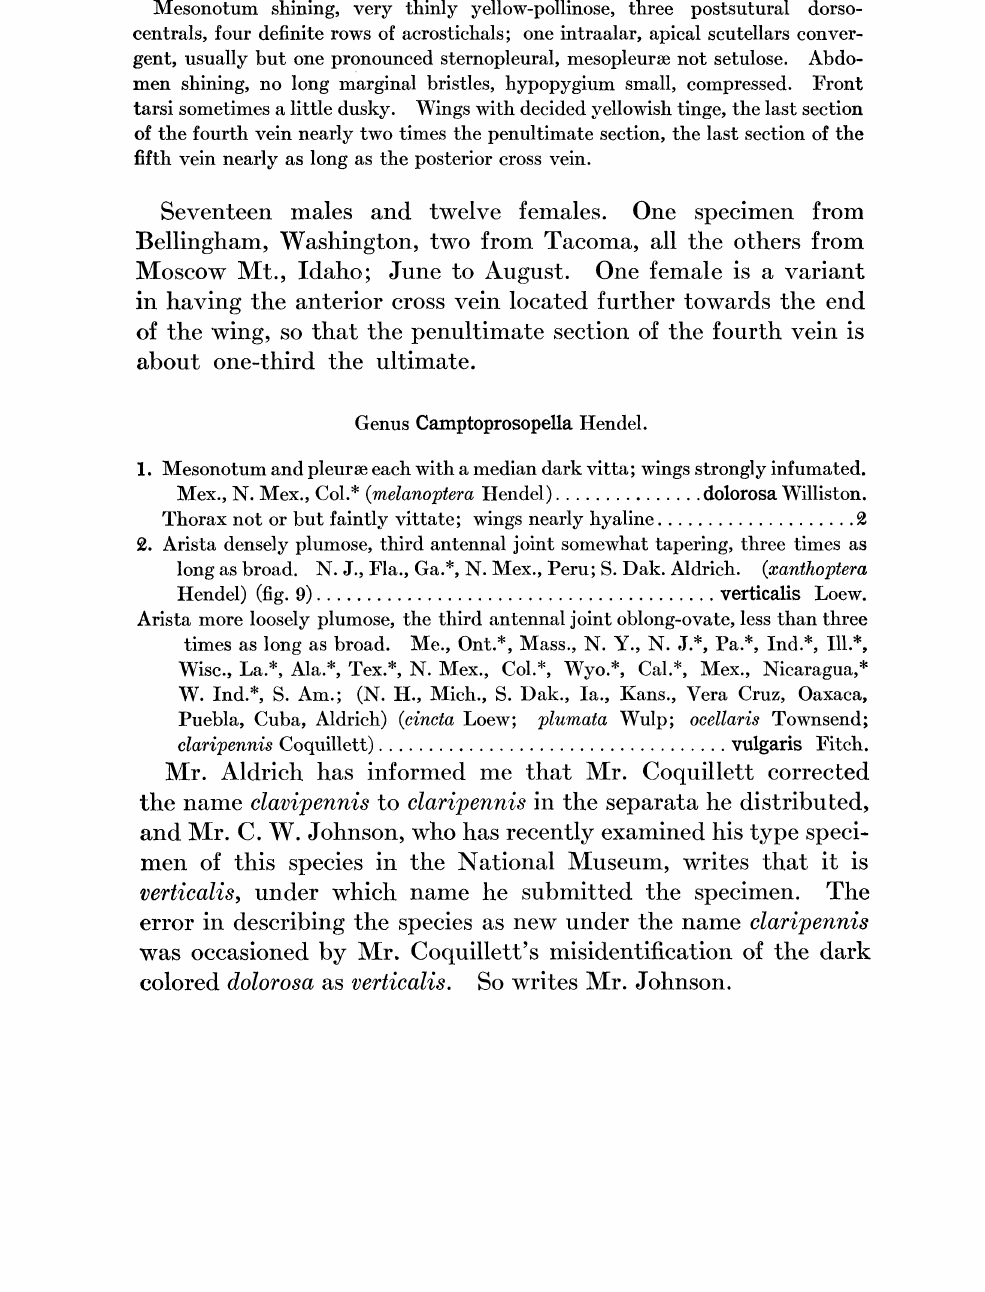
in color pale yellow, neither shining nor sericeous, the central part of the face is twice as broad as the sides: cheeks scarcely one-half the eye-height, the lower edge with minute hairs: palpi and proboscis yellow, rarely the tip of the palpi blackened: Third antennal joint oval, one-half longer than broad, the outer third to half black- ened, the arista microscopically pubescent. Mesonotum shining, very thinly yellow-pollinose, three postsutural dorso- centrals, four definite rows of acrostichals; one intraalar, apical scutellars conver- gent, usually but one pronounced sternopleural, mesopleurm not setulose. Abdo- men shining, no long marginal bristles, hypopygium small, compressed. Front tarsi sometimes a little dusky. Wings with decided yellowish tinge, the last